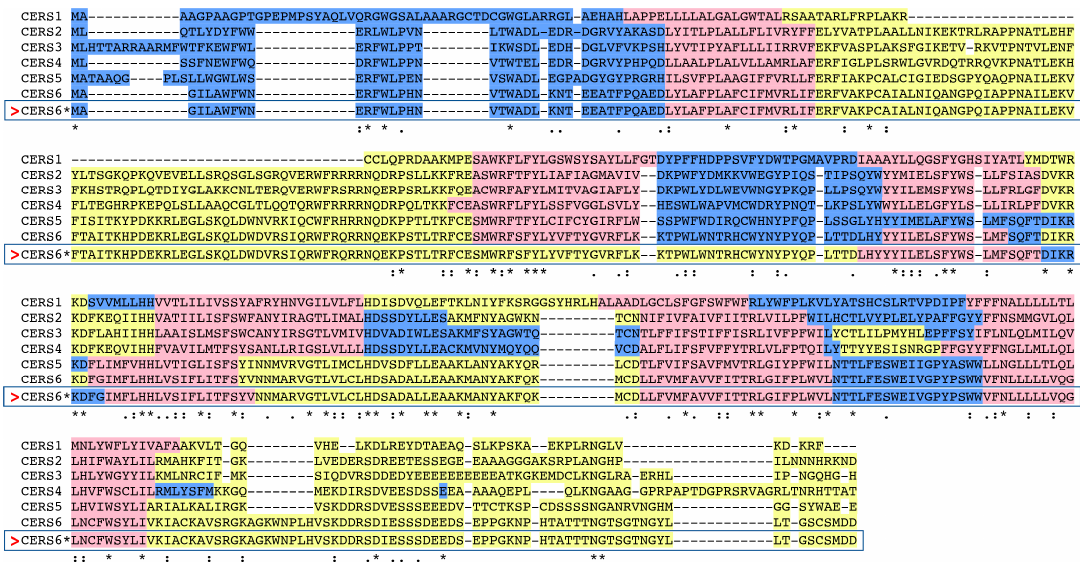
Figure 3. Amino acid sequence alignment of human CERS enzymes. Sequence sources are listed in Tables 1 and 3. The PSI/TM-Coffee software was used to align sequences and map membrane domains. Predicted lumenal sites are shown in blue; predicted transmembrane sequences are in pink and predicted cytoplasmic regions are in yellow; *, shows identical residues for all polypeptides; : - similar alternate residues; . - dissimilar alternate residues. Rectangular frame shows the same CerS6 sequence with the alternative domain topology prediction (TMHMM Server 2).